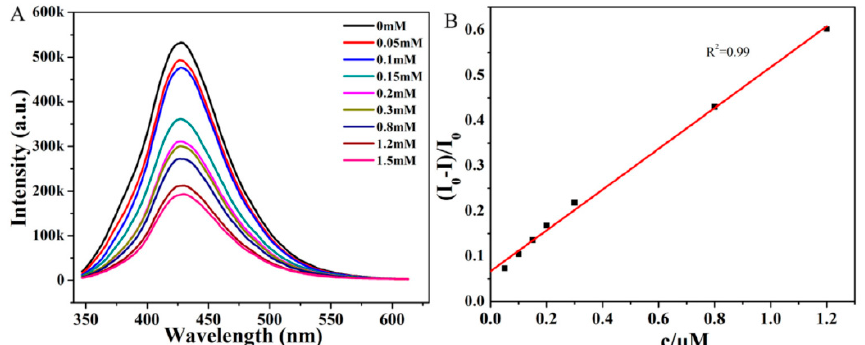
Figure 26. ( A ) Fluorescence spectra of MoS 2 QDs with different concentrations of hydrogen peroxide. ( B ) Linear relationship between the fluorescence intensity and H 2 O 2 concentration. Reproduced with permission from [74]. Copyright Elsevier B.V., 2017.